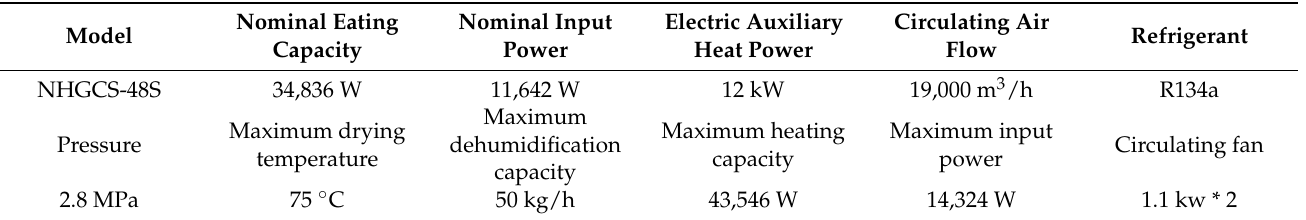
Table 1. The main parameters of the HPCB.